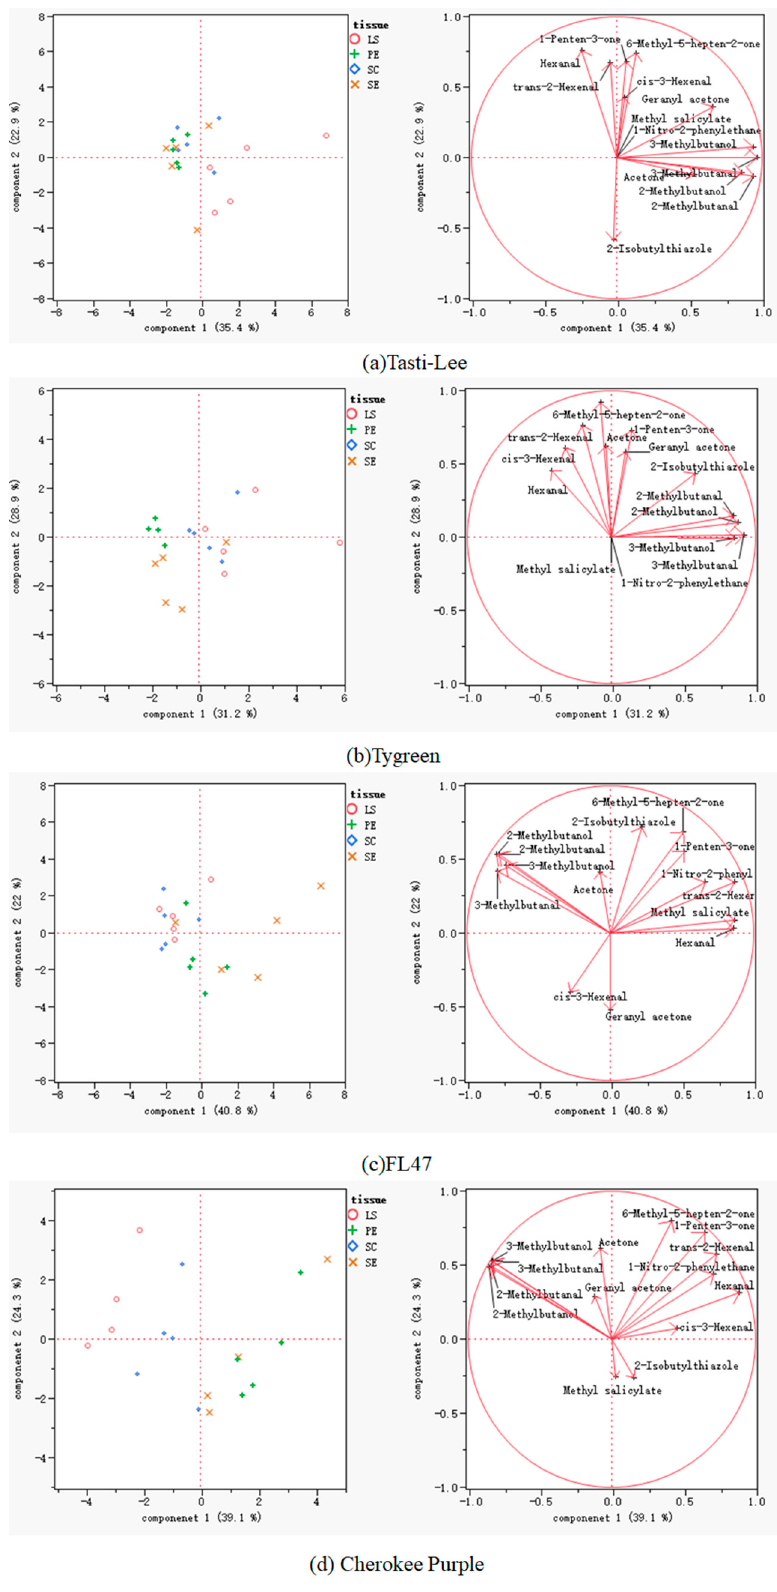
Figure 3. Principal component analysis (PCA) result of different tissues.